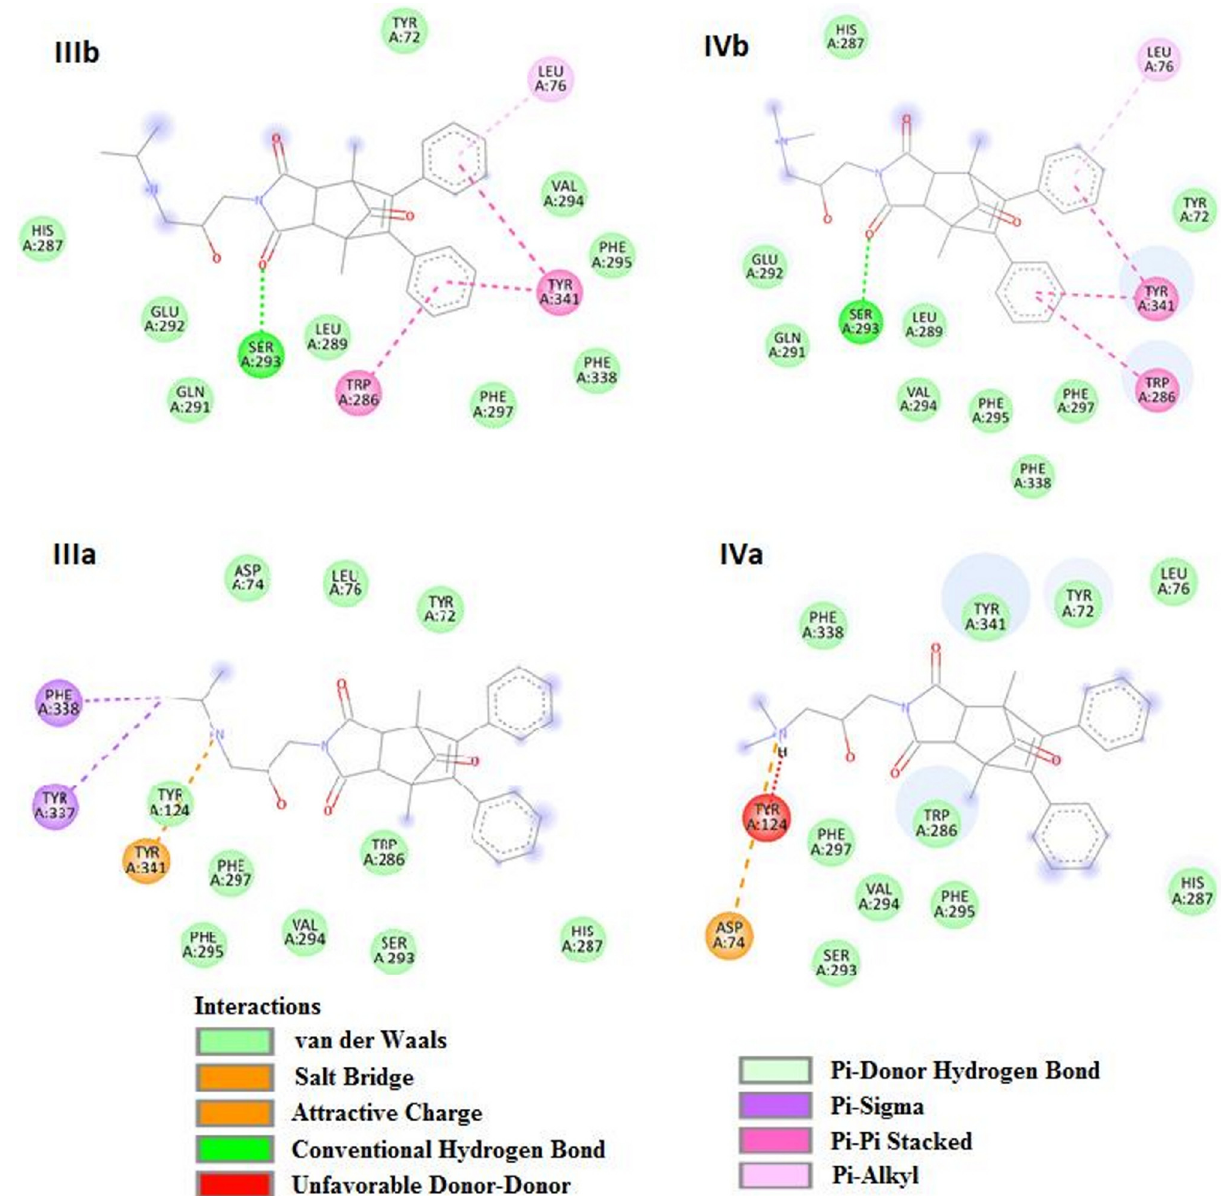
Figure 7. Structure of the active site of AChE and potential types of interactions of two binding modes ( a , b ) between the competitive inhibitors III and IV and amino acids in the PAS of the en- zyme.